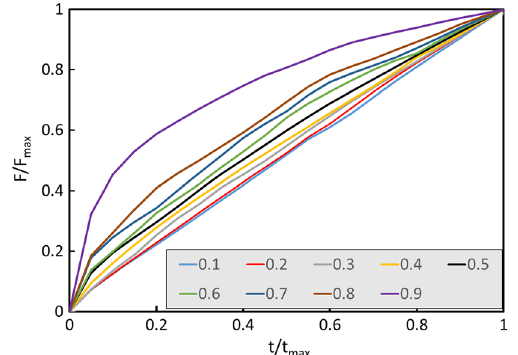
Fig. 9 Percentiles of the dimensionless cumulative infiltration ( F / F max ) versus the dimensionless time ( t / t max )